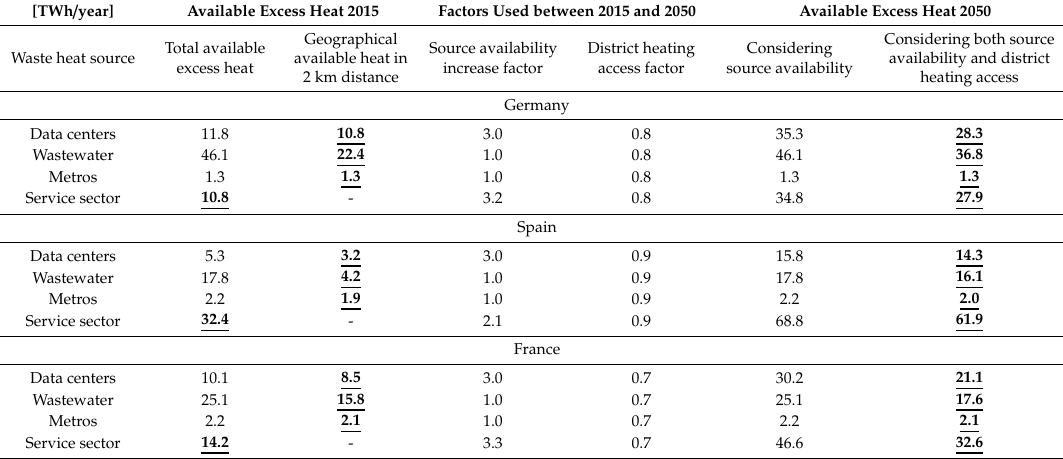
Table 3. Available excess heat assumed to be located near potential DH areas, hence available to DH supply. The table shows the potentials divided into countries and heat sources for 2015 and the projections for 2050. The bold underlined values are the potentials used in the